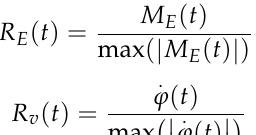
( c ) Figure 23. The results of a no-friction flap ( 𝑇 (cid:3017)(cid:3021)(cid:3016) = 0 ) with various values of PTO damping 𝐶 (cid:3017)(cid:3021)(cid:3016) under unit-amplitude regular waves: ( a ) CWR; ( b ) time–averaged capturing power; ( c ) angular ve- locity amplitude.